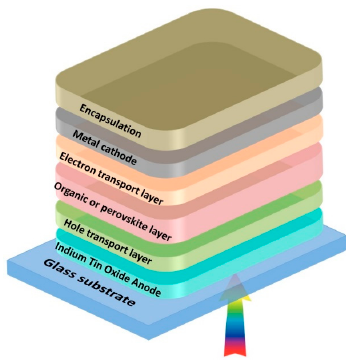
Figure 2. A schematic diagram of an organic or perovskite solar cells structure with an encapsulation layer.